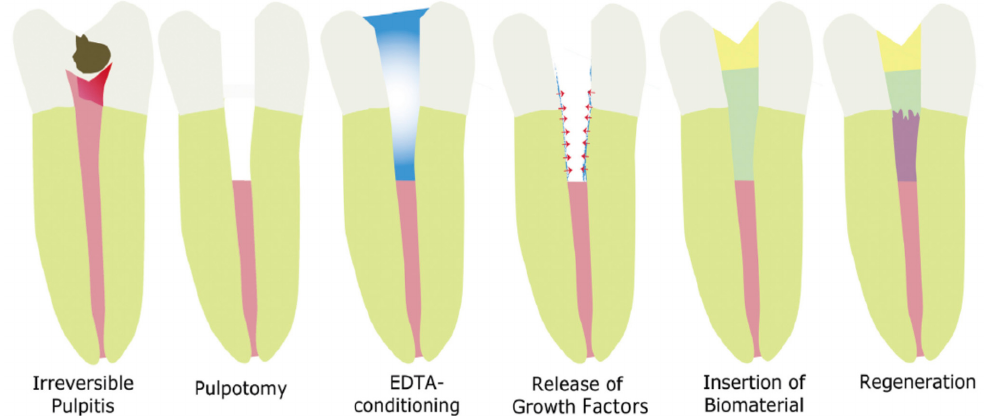
Figure 2. Clinical procedure for dental-pulp regeneration using a cell-free approach [119].